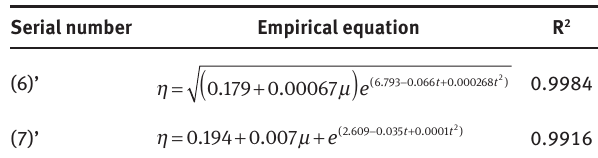
Table 6: The empirical equations for kinematic viscosity, oxidation degree and temperature of